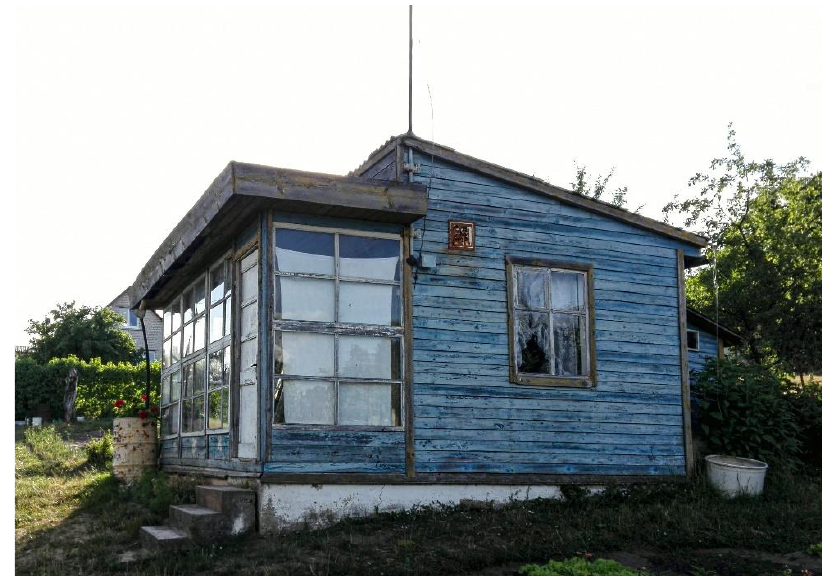
Figure 11. Garden house in Pupojų st., Vilnius. Photo by A. Gabrėnas .